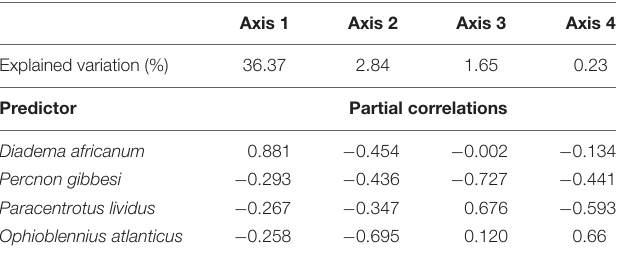
TABLE 4 | Variation in benthic transect explained by each coordinate axis of the best DistLM solution (%) and correlations with orthonormal variables (predictor